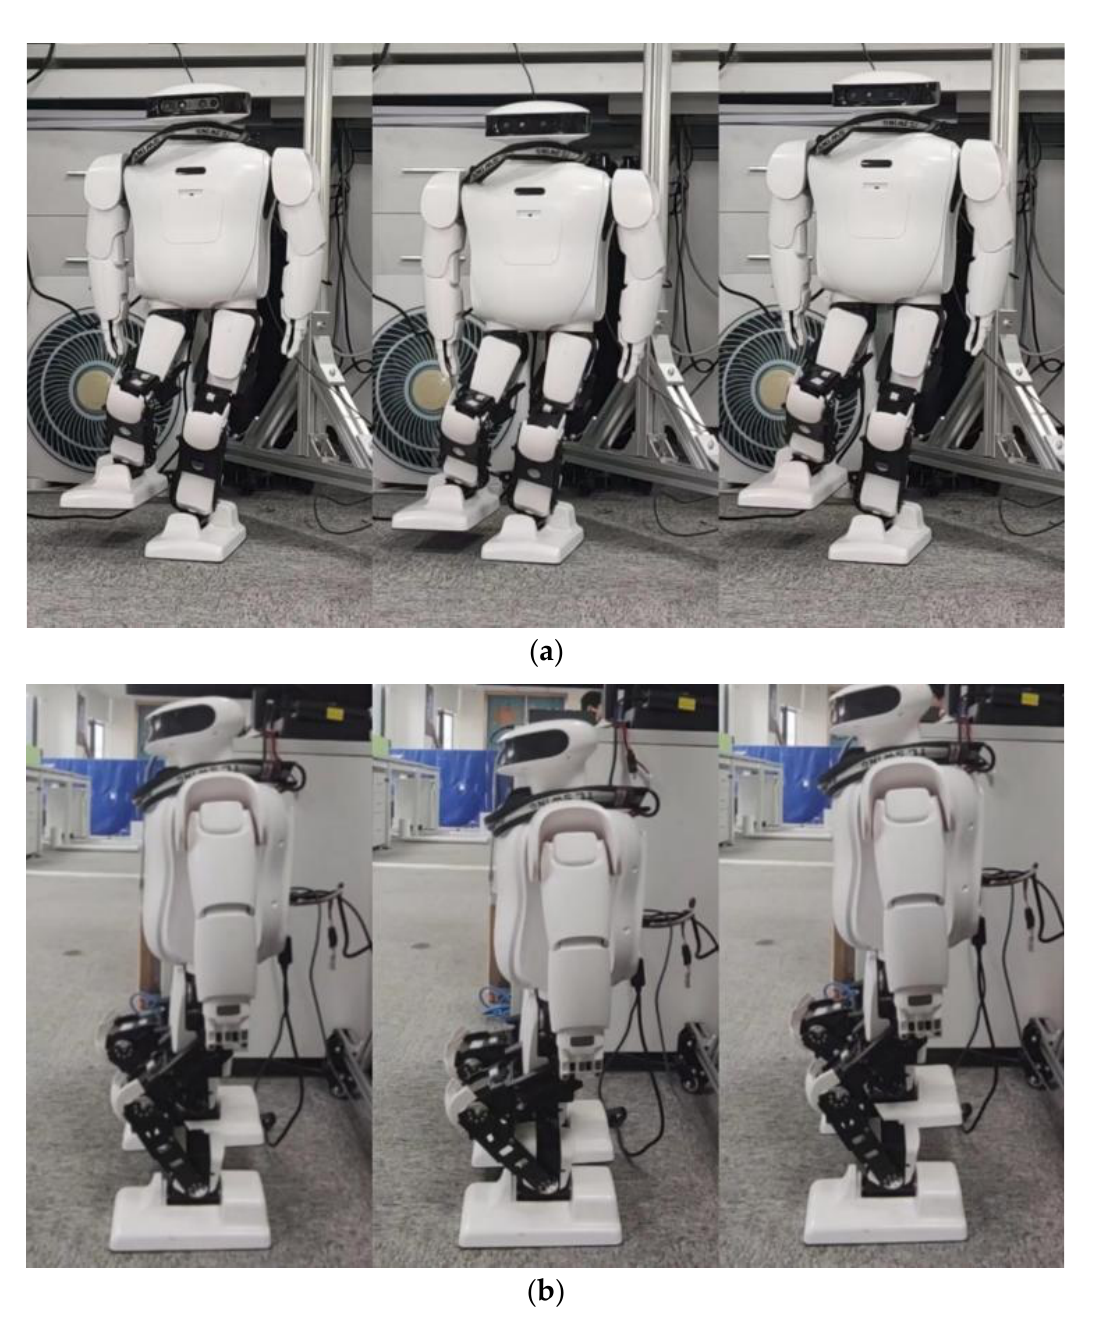
Figure 14. When Roban’s COM moves 5 cm, it completes three squats on a single leg with spring compensation. ( a ) A main view of the robot squatting process with spring compensation. ( b ) A side view of the robot squatting processwith spring compensation.